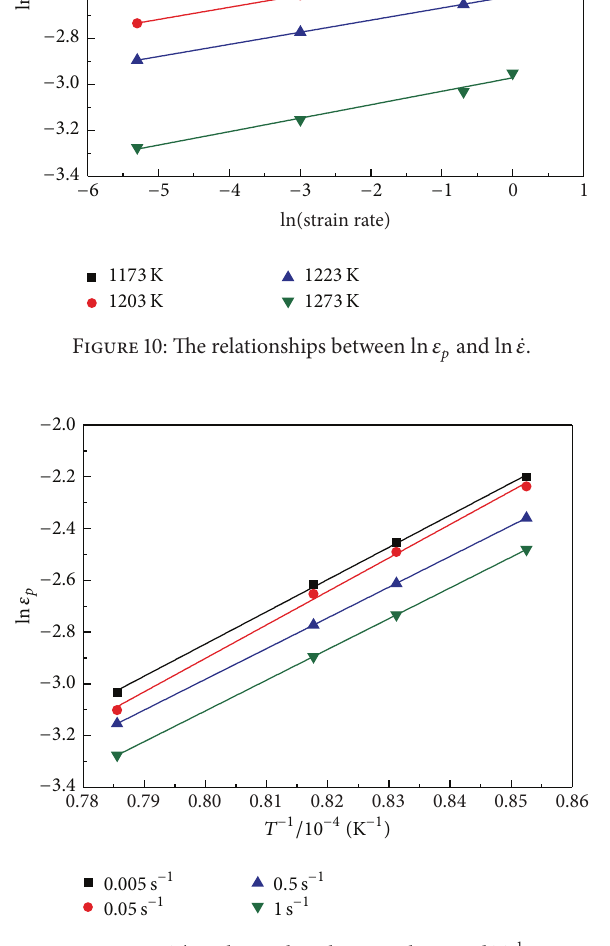
ln 𝜀 𝑝 (as shown in Figure 11), respectively. We can get 𝑚 1 = = 98754.78 J / mol. 𝛼 0.05281 ; Q 1 1 is then obtained by using (13), 𝛼 1 = 4.429 × 10 −6